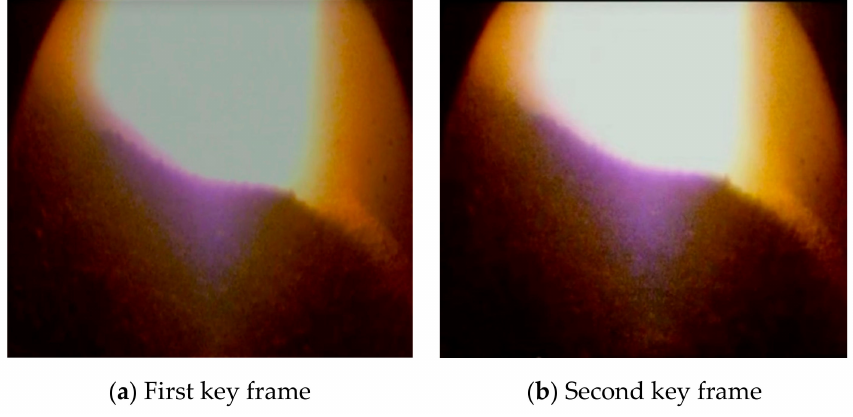
Figure 11. Selected key frames.